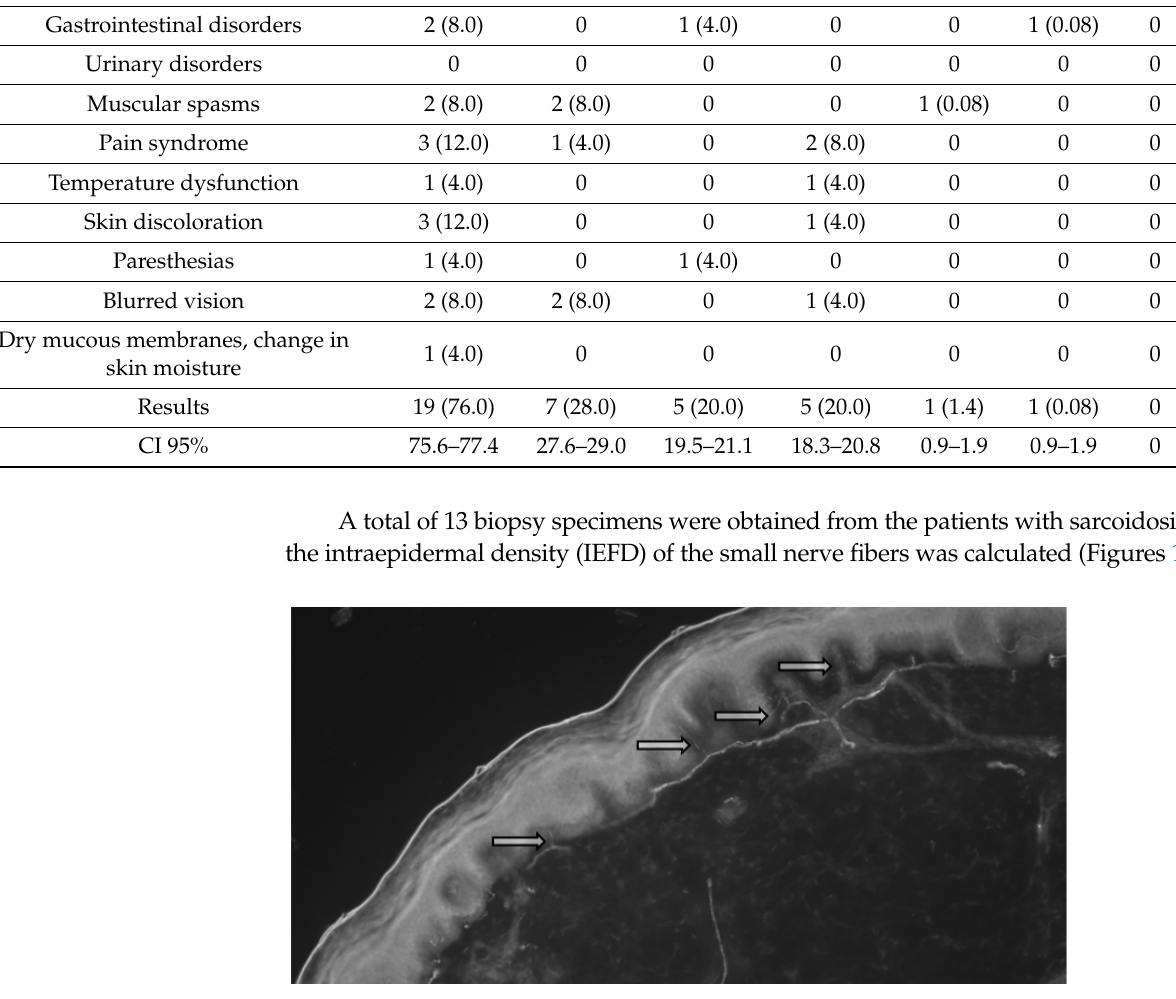
Figure 2. Skin biopsy of patient with sarcoidosis (enzyme immunoassay, male, 34 years). A total of 13 of the biopsies were obtained from patients with sarcoidosis (Table 4). The calculations of the intraepidermal density of the small fibers were performed in ac- cordance with the values obtained from the worldwide normative reference study [23]. Table 4. Intraepidermal nerve fiber density (IEND) in patients with sarcoidosis. Group IEND in 1 mm, Median (Q1; Q3) Normal Values—Median Normal Values—0.05 Quantile Pulmonary sarcoidosis ( n = 13) 7.68 (7.02;8.34) 12.4